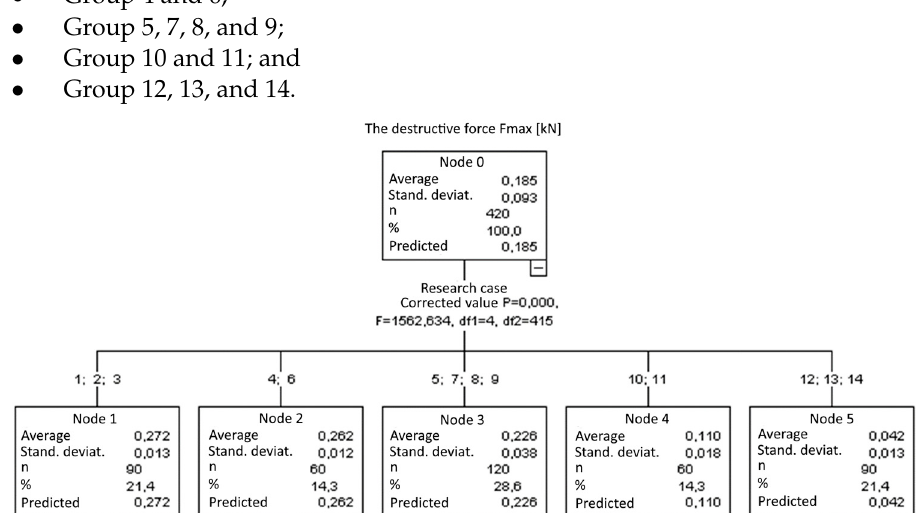
Figure 19. Classification tree for the breaking force F max .